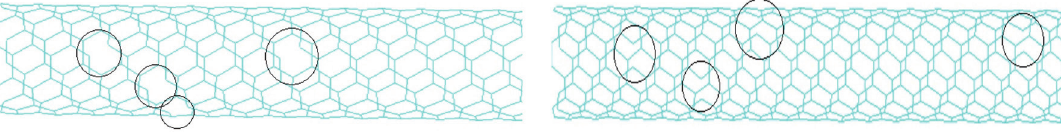
Figure 13. The locations of four broken covalent bonds in (5, 5) CNT leading to the highest reduction (left) and the lower reduction (right) in CNT modulus.